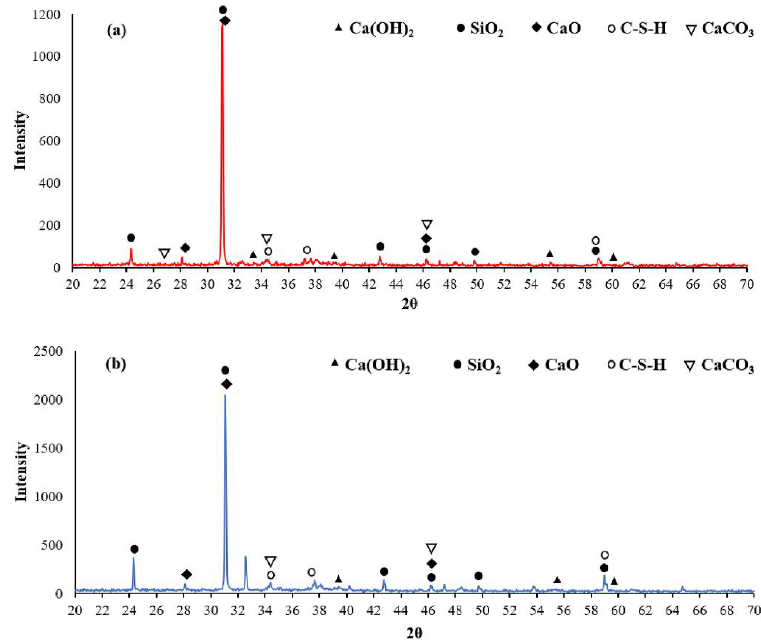
Figure 6. XRD spectra of ( a ) control sample and ( b ) NS sample concrete [60].